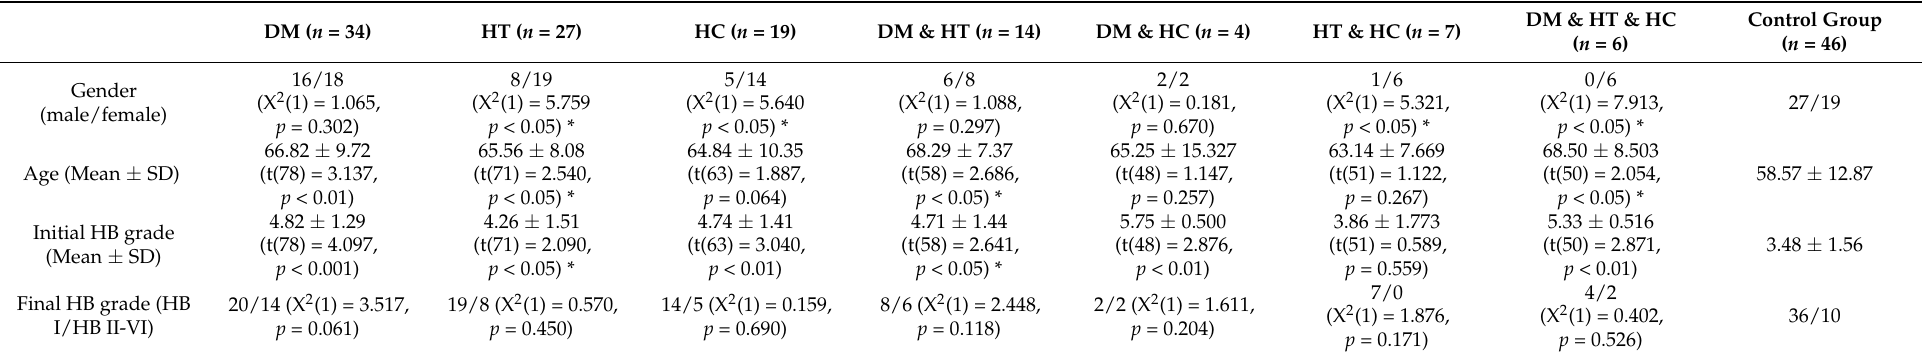
Table 3. Correlation of diabetes mellitus (DM), hypertension (HT), hypercholesterolemia (HC), and DM and HT with gender, age and initial—final House–Brackmann (HB) grade in patients suffering from Bell’s palsy. * Statistical significance ( p <